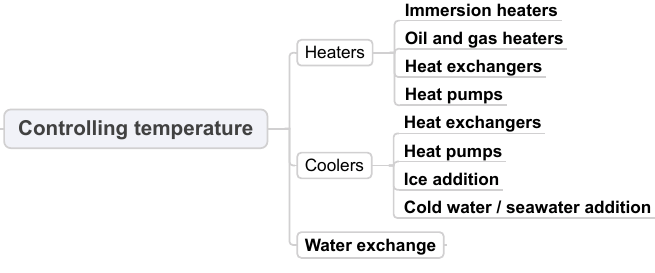
Figure 10. Taxonomy: controlling temperature.